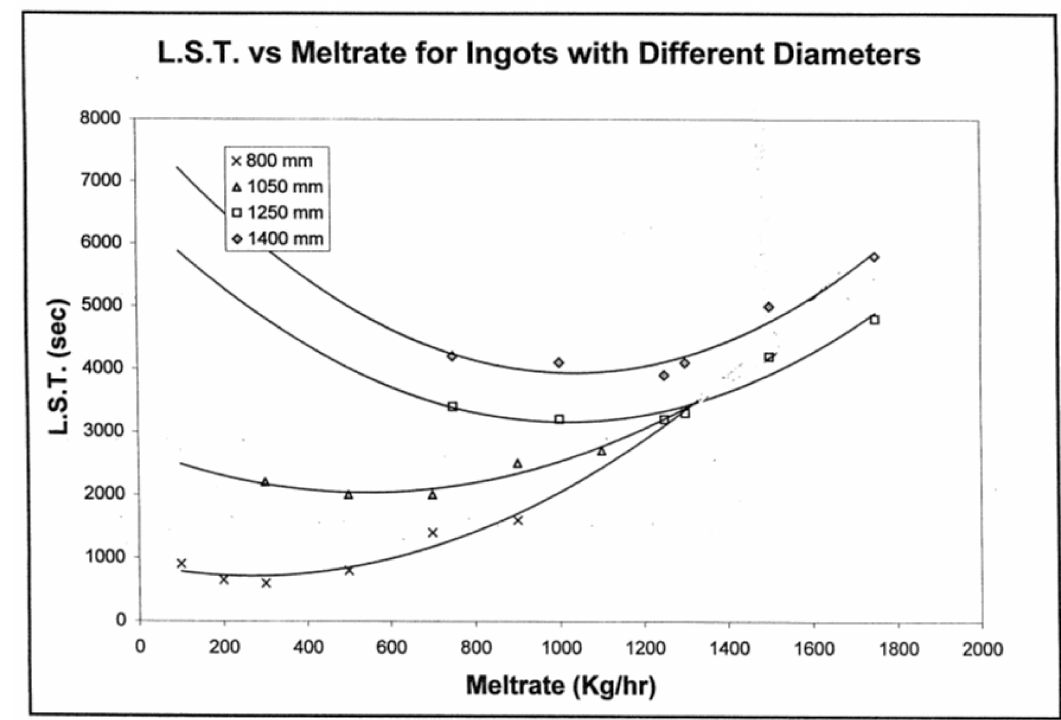
Figure 1. Longest Solidification Time (LST) versus melt rate for ingots with different diameters [33]. As long as the ingot solidifies in a columnar-dendritic manner, the angle between the columnar dendrites direction and the bottom of the liquid steel pool is 90 ◦ at the center position of the ingot